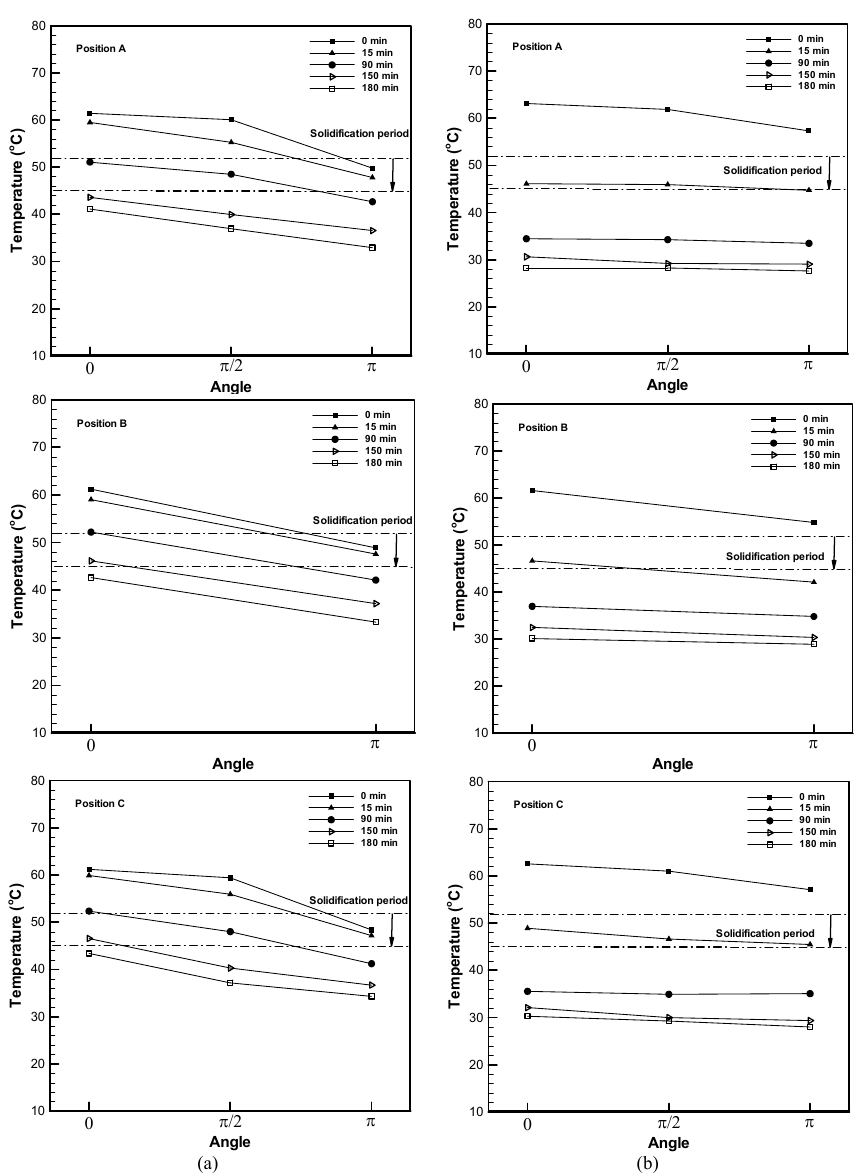
Figure 10. Experimental results of temperature distribution for 26mm height fins heat exchanger for different angles during discharging process for Ste = 0.26: (a) 32.5mm radial distance and (b) 12.5mm radial